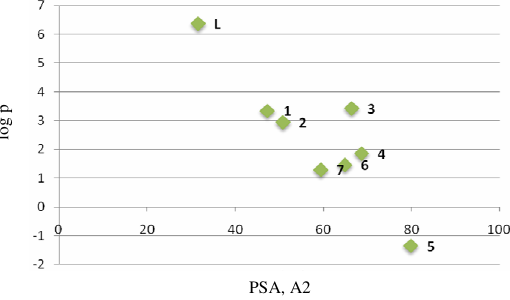
Figure 4. Two - descriptor model for solubility and absorption